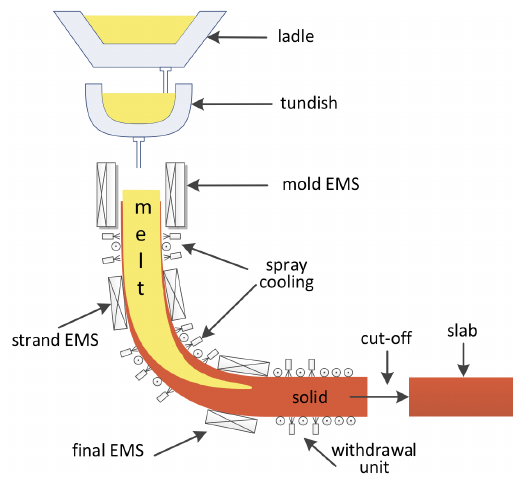
Figure 1. A schematic diagram of the continuous casting